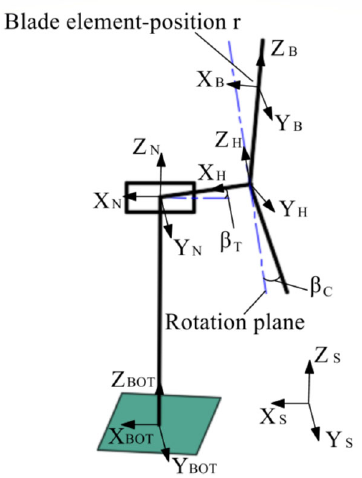
Figure 4. Horizontal axis wind turbine coordinate system.